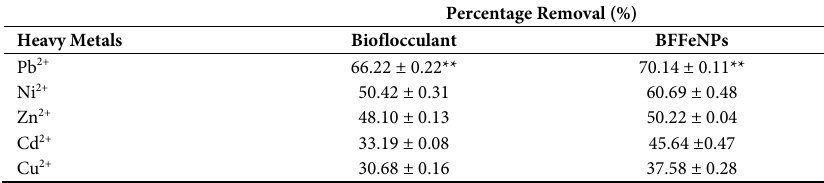
Table 2. The percentage removal of heavy metals from real wastewater